Question: According to the figure, is the described quantity increasing or decreasing?
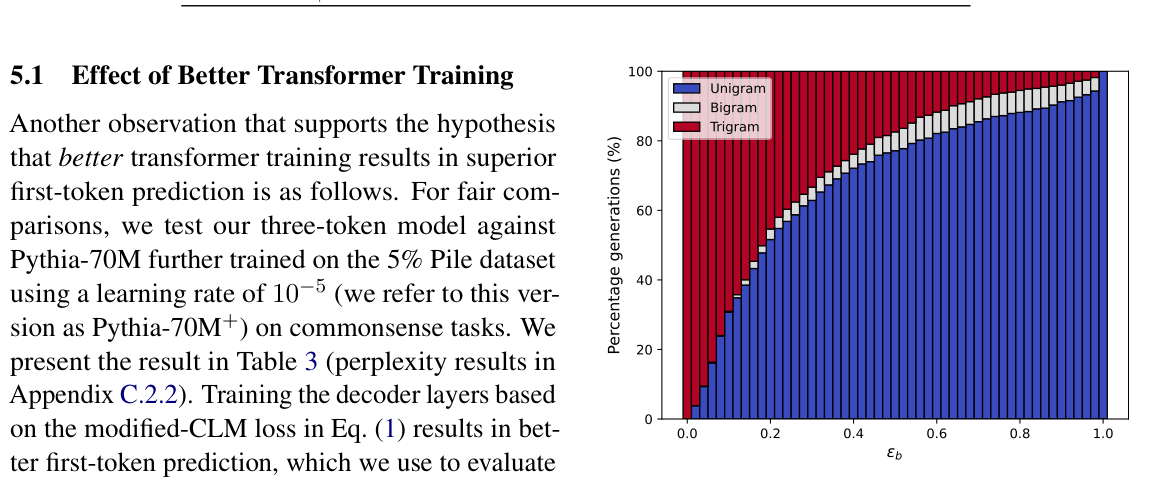
Answer: increasing